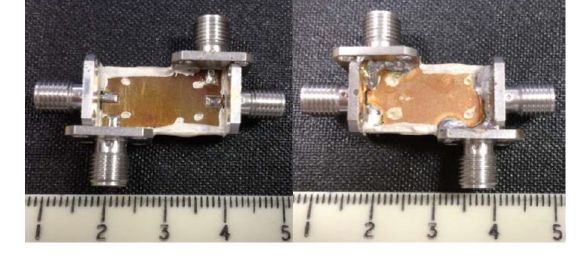
Figure 20. The proposed wide-band balanced BPF [91]: ( a ) Photographs for the prototypes; ( b ) S- parameter performances.